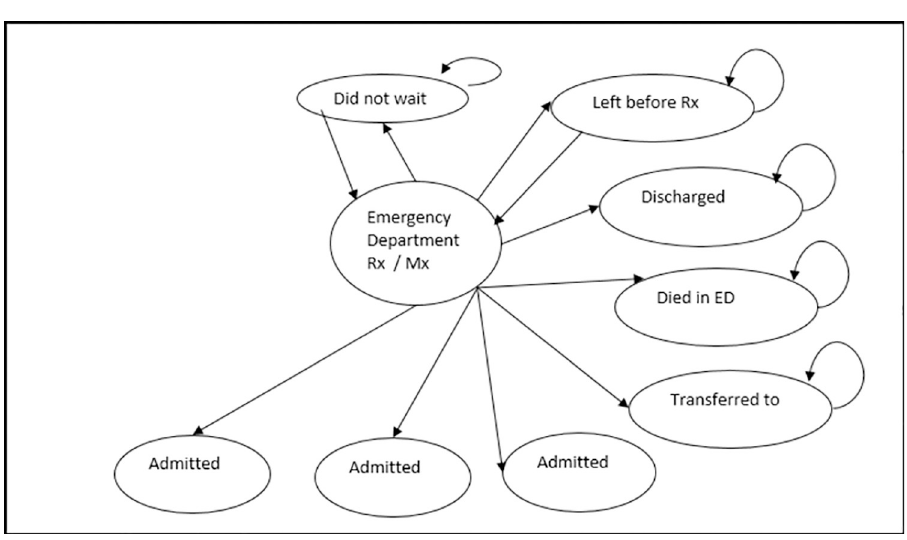
Fig 1. Pictorial representation of the decision-analytic